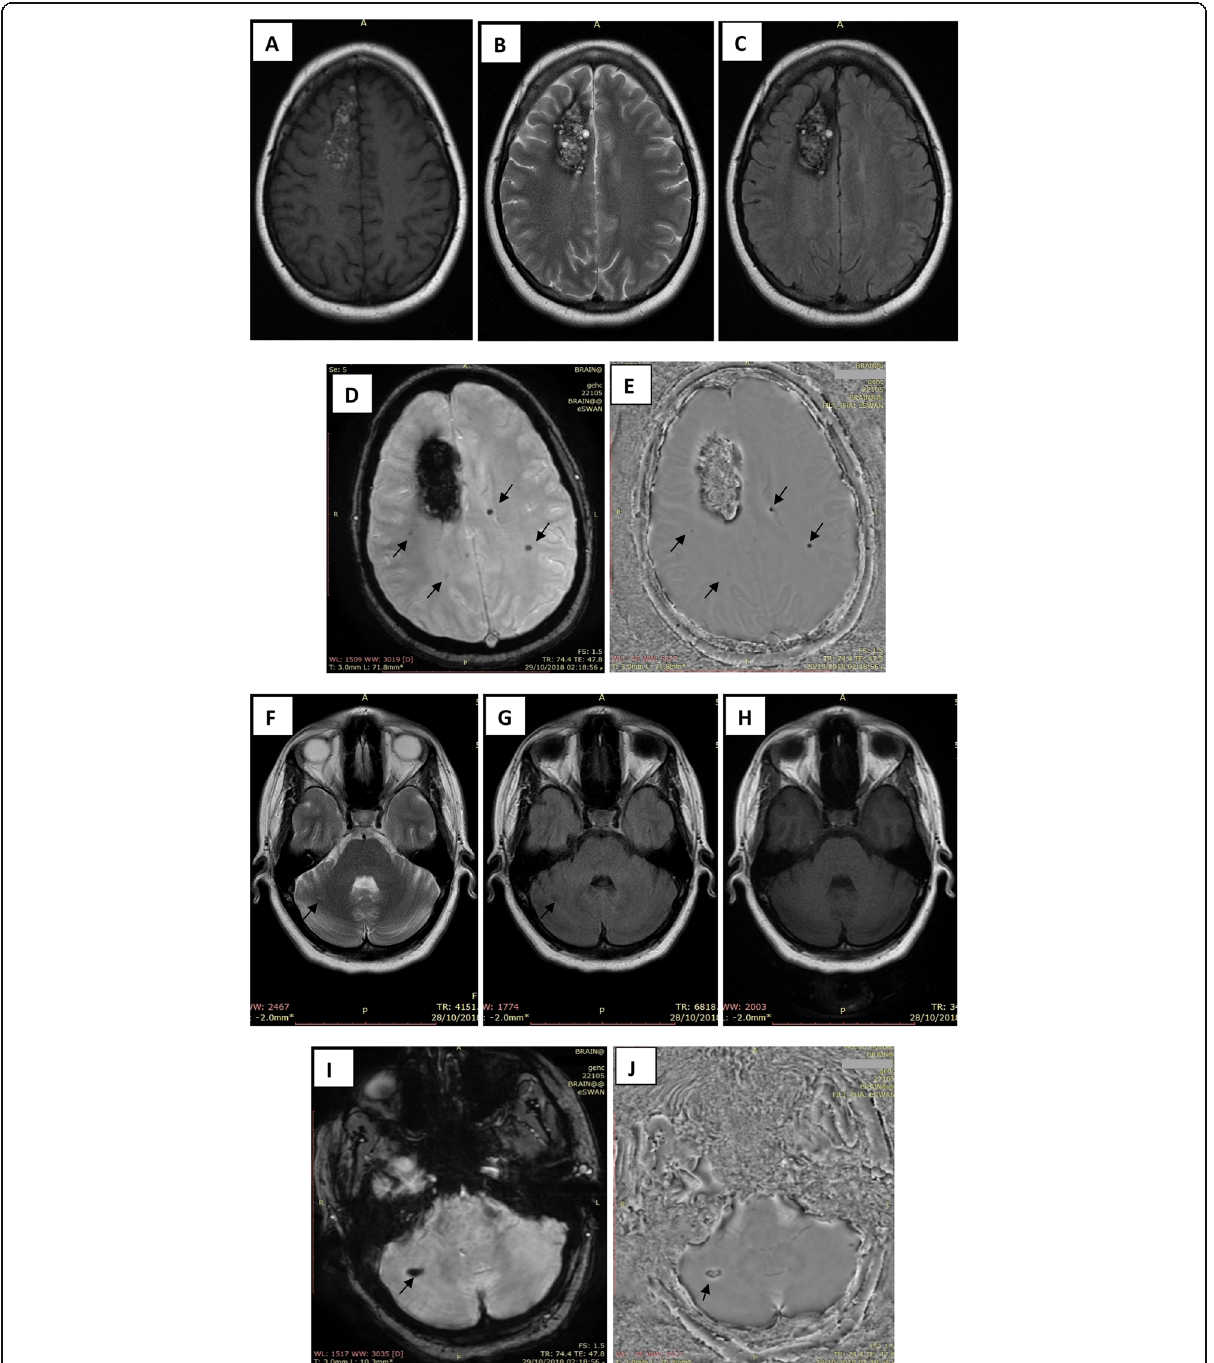
Fig. 1 Female patient aged 45 years old presented with severe headache and confusion. MRI brain was done and showed right upper frontal cavernoma together with multiple microbleeds that were inconspicuous in T1WI, T2WI, and FLAIR sequences ( a , b, and c ) but are evident in SWI ( d ) confirmed by low signal intensity in filter phase ( e ). Lower level in the same patient showed another right much smaller cerebellar cavernoma that was overlooked by conventional MRI sequences, faint hyperintense in T2WI ( f ), and faint hypointense in FLAIR ( g ), and no lesion could be detected in T1 WI ( h ) but becomes obvious in SWI and filter phase ( i and j